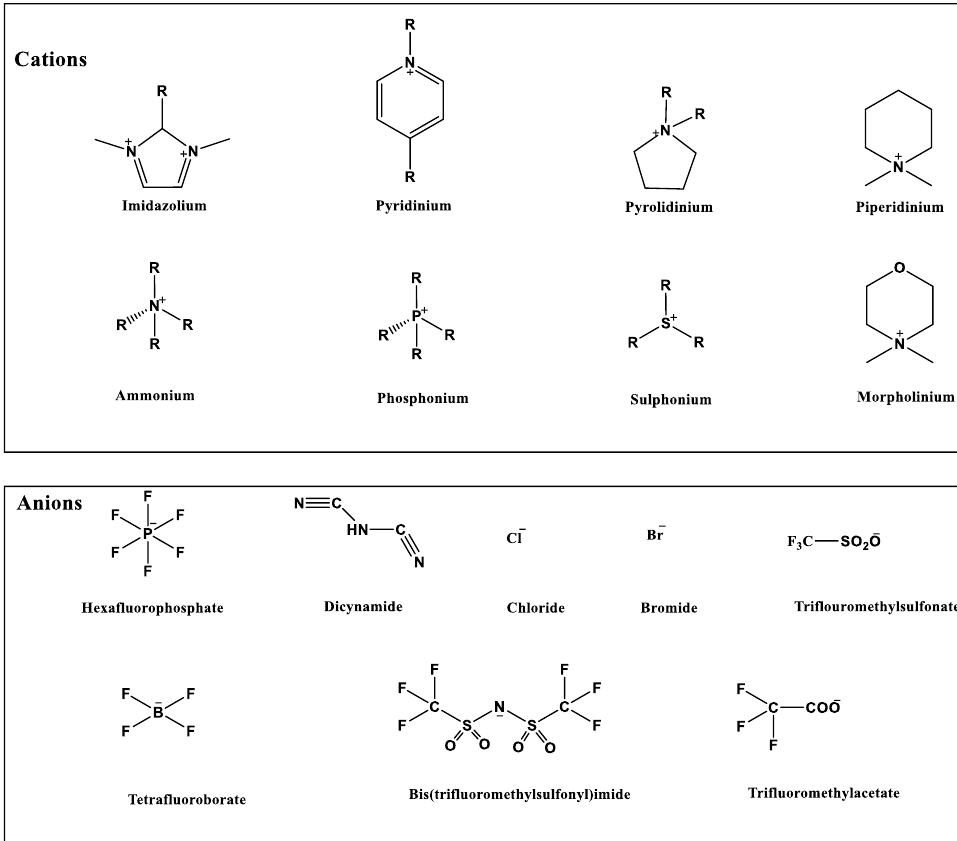
Figure 2. Names and chemical structures of the most studied IL cations and